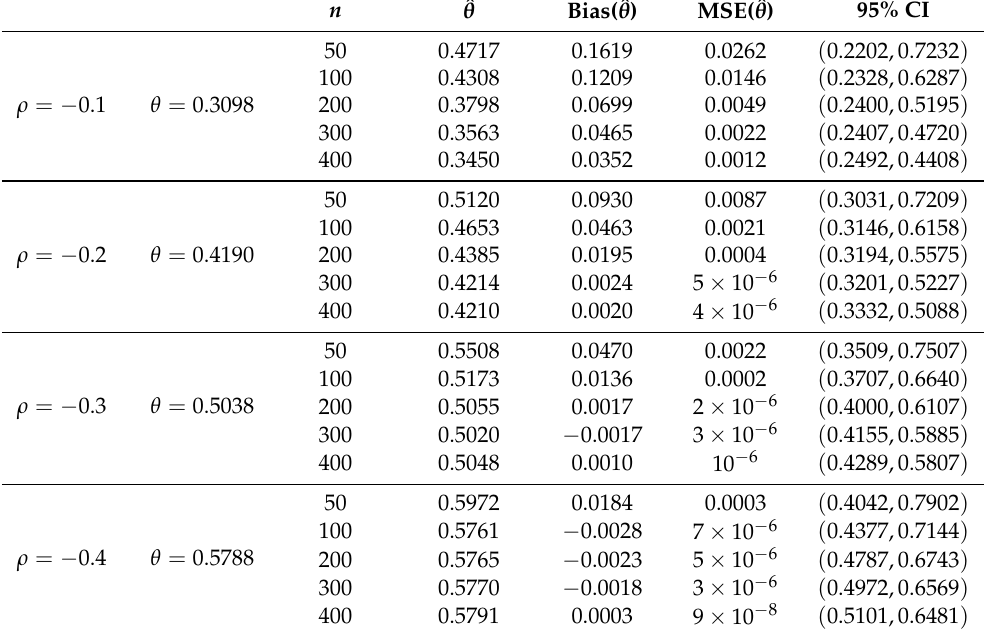
Table 1. Moment-based estimation for θ .